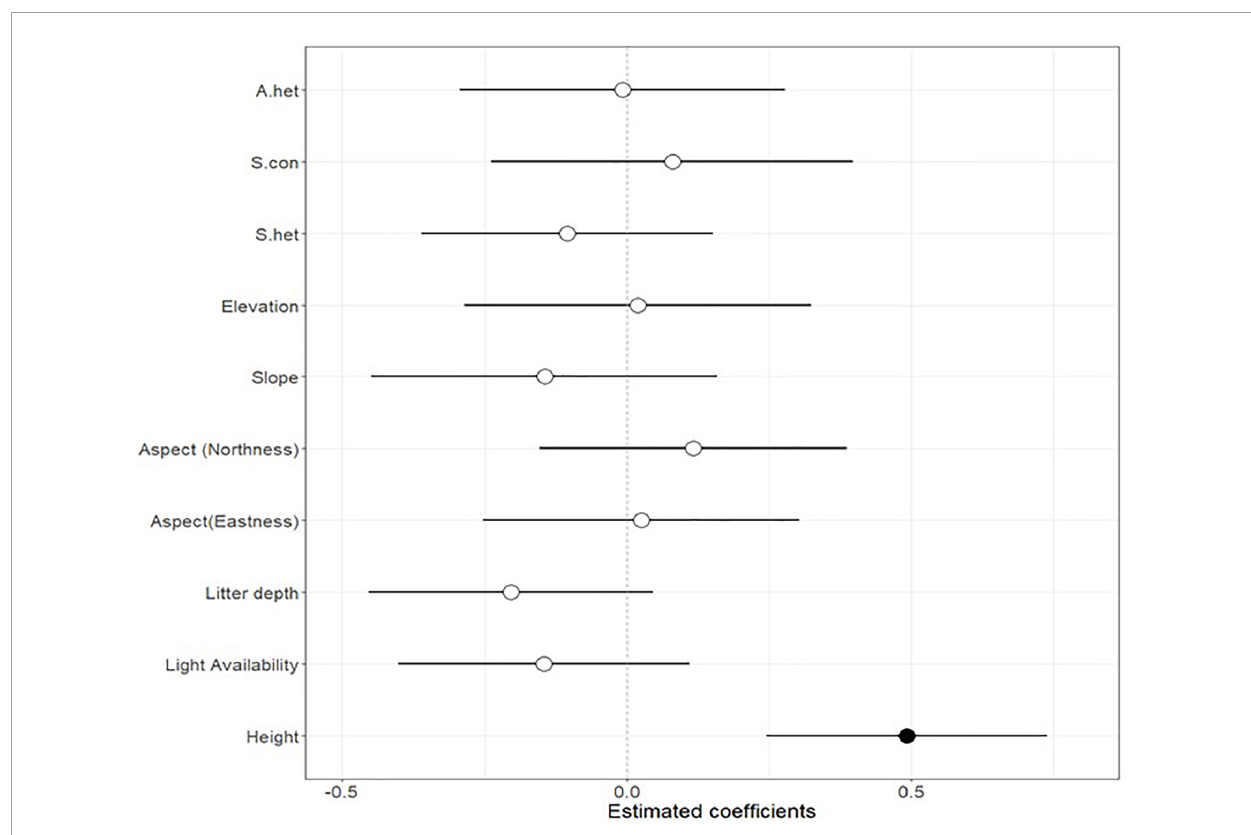
FIGURE3 Parameter estimates ( ± 2 SE) from generalised linear mixed effects model (GLMM) fitted to test the effects of abiotic and biotic factors on seedling survival of liana species in the Ngel Nyaki forest. Filled points indicate significant effects ( P < 0.05).